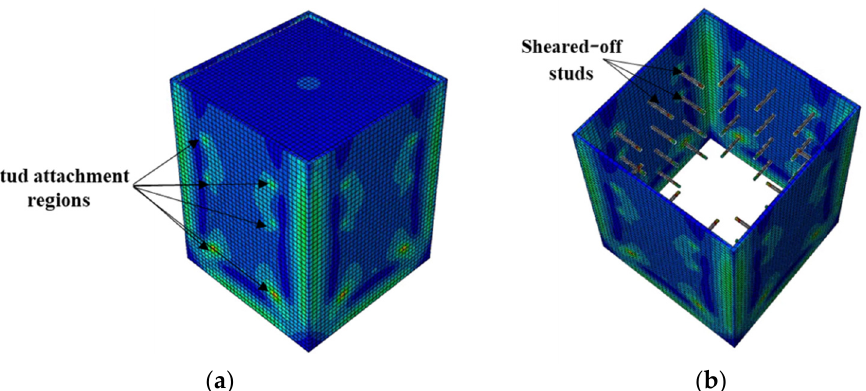
Figure 12. Typical failure mode of CFST columns with shear studs on four faces: ( a ) stress distribution and ( b ) failure mode.